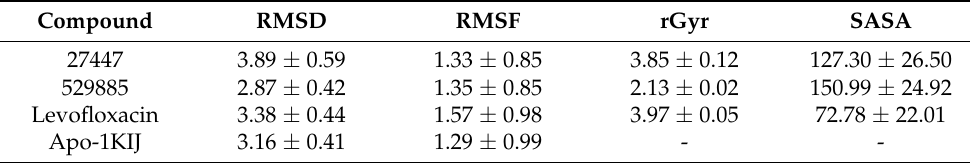
Table 6. MD simulation properties of the native protein and of the protein–ligand interactions. Compound RMSD 27447